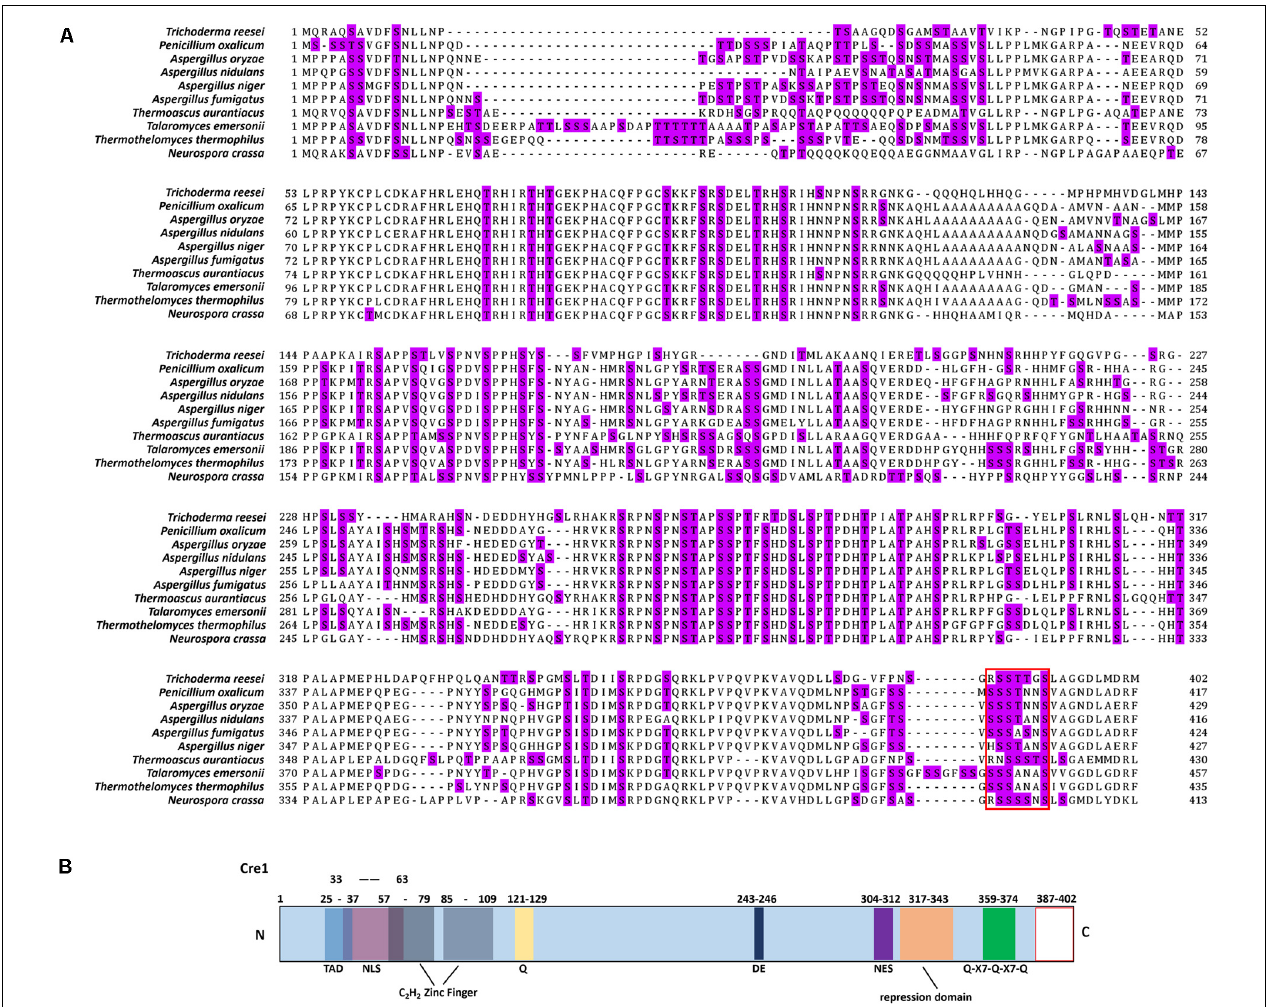
FIGURE 1 | Amino acid sequence alignments of Cre1/CreA and in silico domain prediction of Cre1. (A) Amino acid sequence alignments of Cre1/CreA from Trichoderma reesei , Penicillium oxalicum , Aspergillus oryzae , Aspergillus nidulans , Aspergillus fumigatus , Aspergillus niger , Thermoascus aurantiacus , Talaromyces emersonii , Thermothelomyces thermophilus , and Neurospora crassa ; S/T phosphorylation sites are highlighted; (B) in silico domain prediction of Cre1. Numbers indicate the amino acid (aa) positions and colored boxes indicate identified C 2 H 2 zink finger domains (gray); pink, nuclear localization signal (NLS); light blue, transactivation domain (TAD); yellow, glutamine (Q); dark blue, aspartic (D) and glutamic (E) acids; green, Q-X7- Q-X7-Q; violet, nuclear export signal (NES); orange, repression domain; blank, C-terminus of Cre1/CreA. The putative domains of Cre1were predicted by a number of in silico prediction tools and alignment algorithms alignment algorithms as described in the section “Materials and